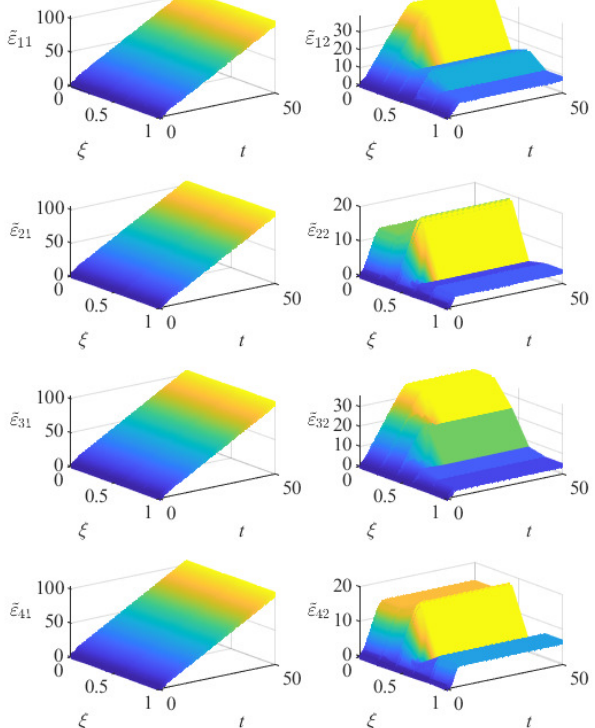
Figure 8. ˜ ε i ( ξ , t ) with control gains d = 1.9 and k = 0 in Example